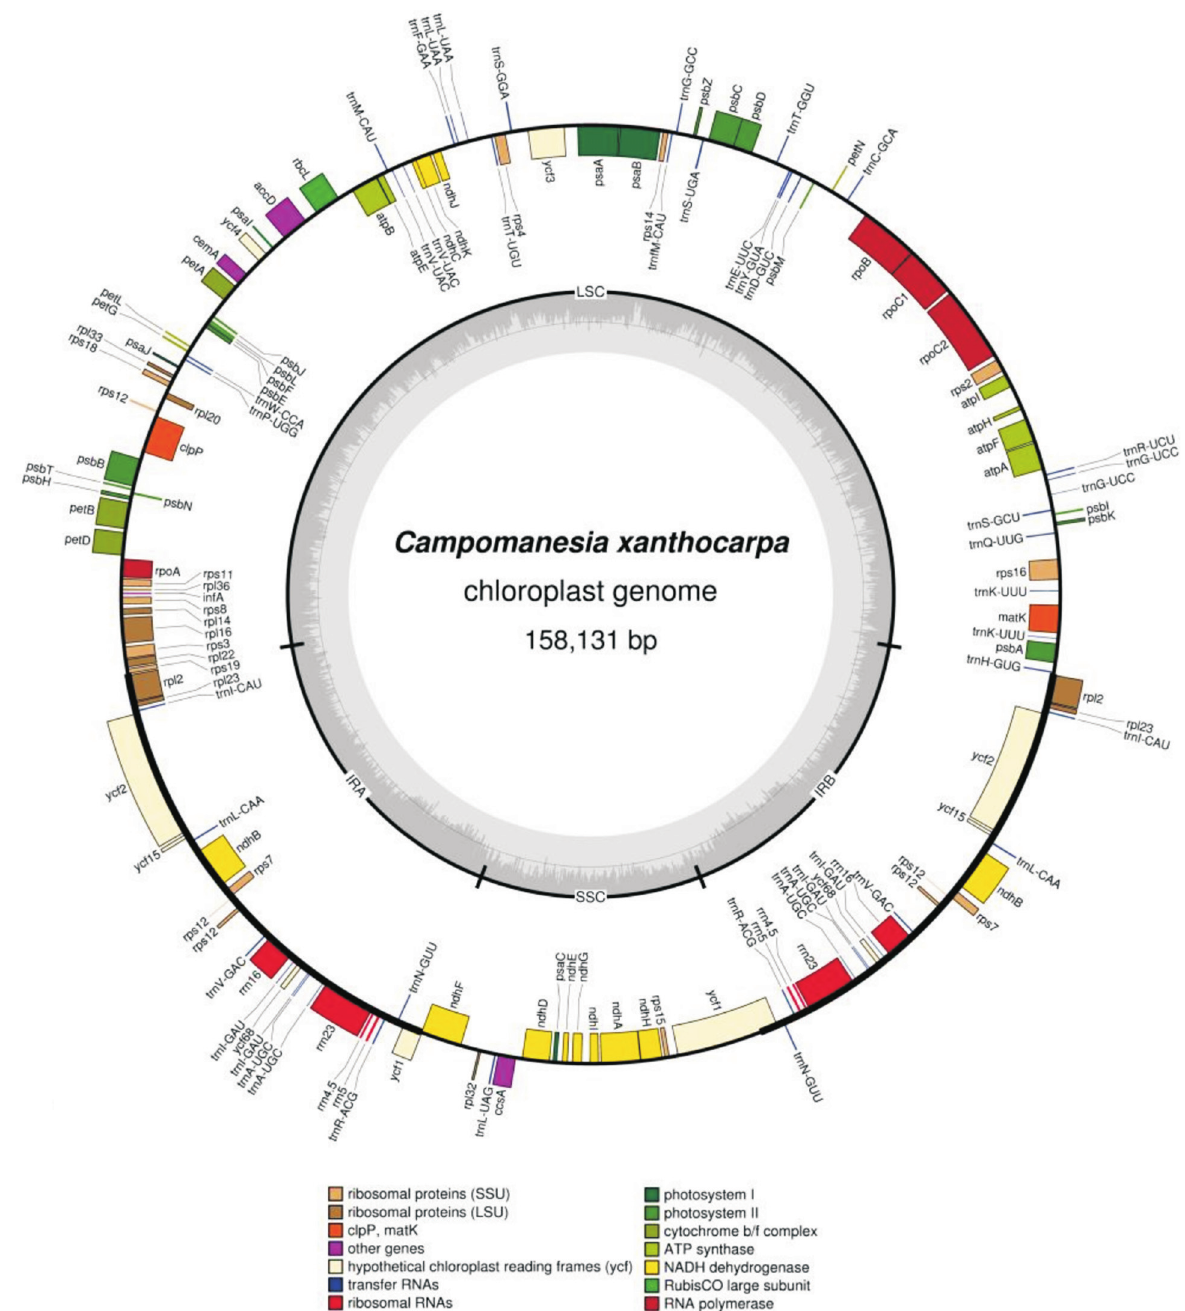
Figure 1 - Gene map of the Campomanesia xanthocarpa chloroplast genome. Genes drawn inside the circle are transcribed clockwise, and genes drawn outside are transcribed counterclockwise. Genes belonging to different functional groups are color-coded. The darker gray in the inner circle corresponds to GC content, and the lighter gray corresponds to AT